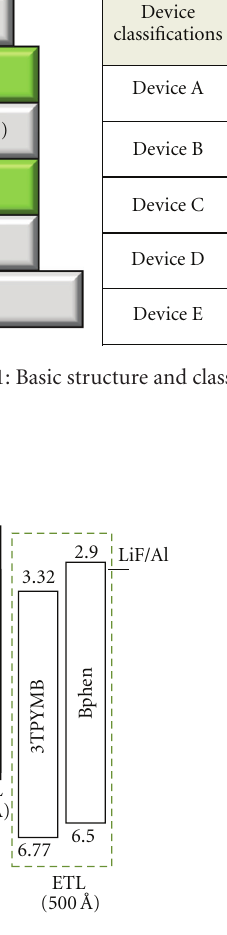
Figure 2: Energy band diagram of the used